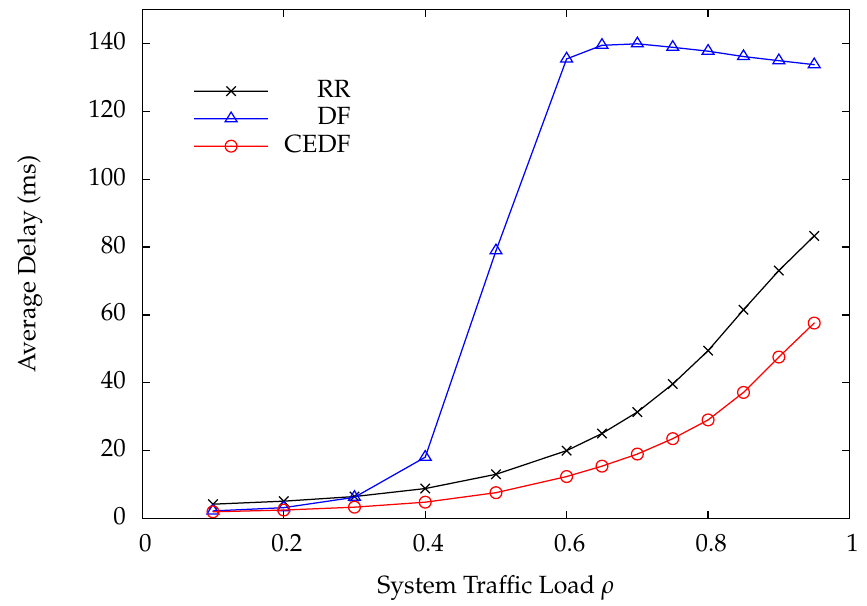
Figure 8. Average delay versus system traffic load ρ .